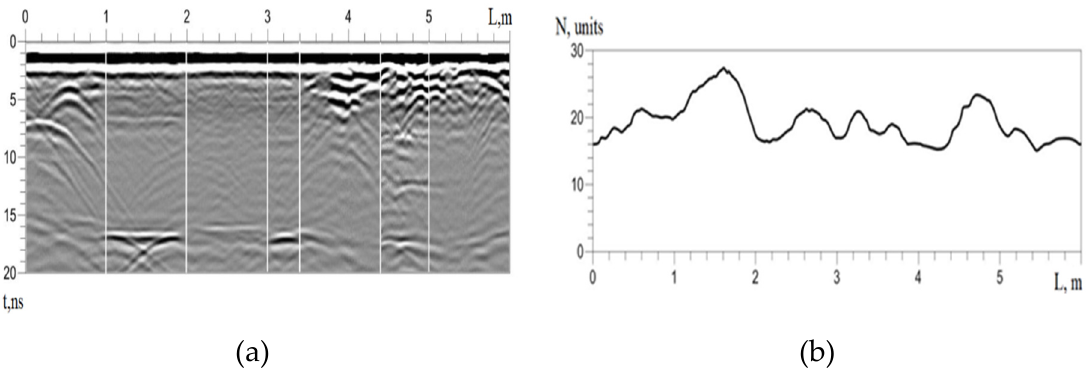
Figure 9. Radargram of the rock mass with the inclusion of ice ( a ) and the curve of the spectrum ripple of the GPR signals ( b ).